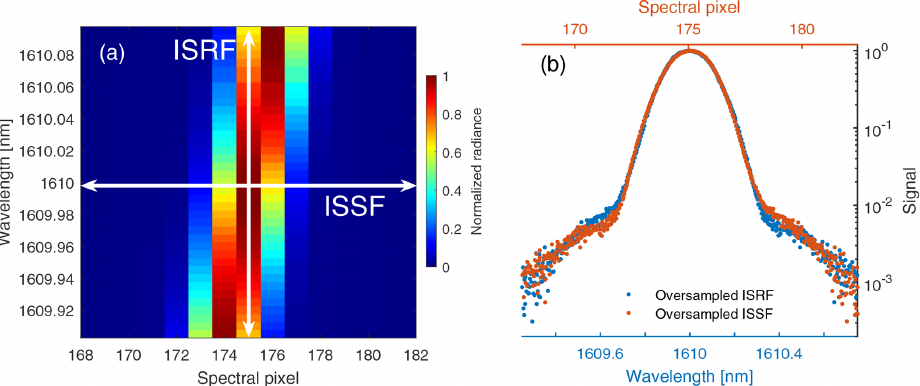
Figure 8. (a) Illustration of ISRFs and ISSFs near 1610nm through the spectral responses of the row that corresponds to spatial pixel 300 of the CH 4 FPA. The laser was scanned from 1609.9 to 1610.1nm with a step size of 0.005nm. (b) Oversampled ISSF and ISRF. The horizontal coordinate of spectral pixel (for ISSF) is aligned with wavelength (for ISRF). The oversampled ISSF will match the ISRF if the profile shown is flipped (not shown here) and the spectral pixel coordinate is projected to wavelength